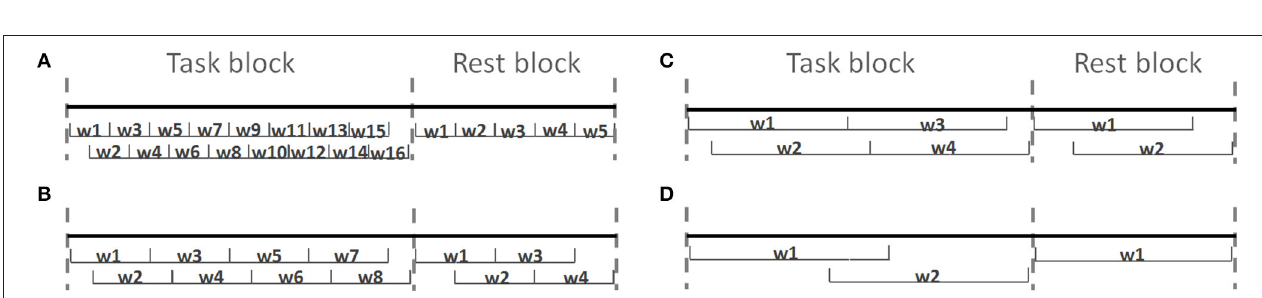
FIGURE 5 | Sample preprocessed EEG + fNIRS data for one of the subjects. Vertical dashes separate different n -back task and rest blocks. (a) Concentration changes of oxy-hemoglobin (red curve) and deoxy-hemoglobin (blue) for channel 17. (b) EEG Time-frequency map of the channel O2.